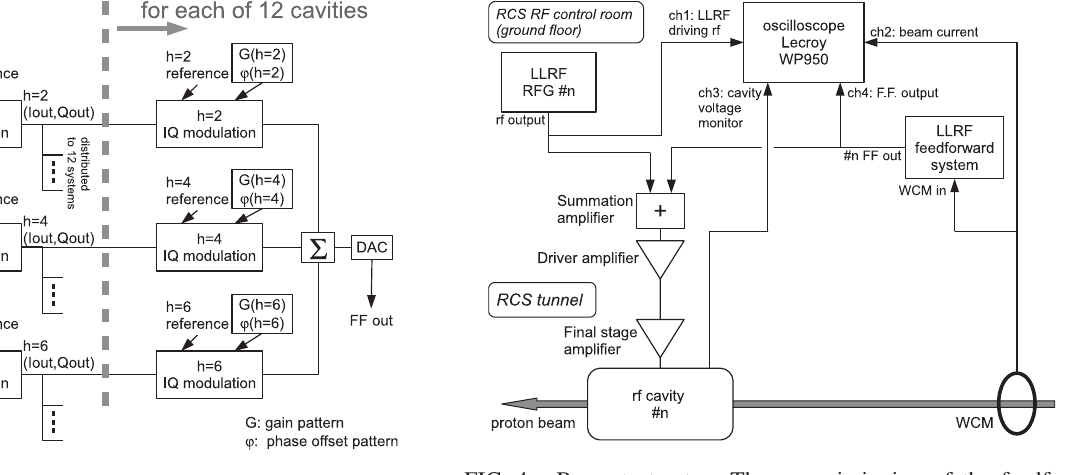
matched.FIG. 3. Block diagram of the multiharmonic rf feedforward